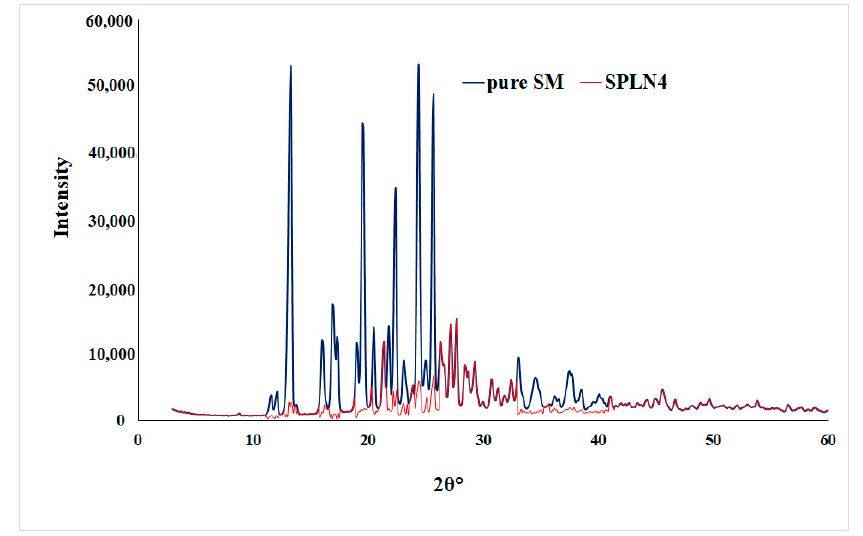
Figure 5. XRD spectra of pure SM and optimized LPHNPs (SLPN4).